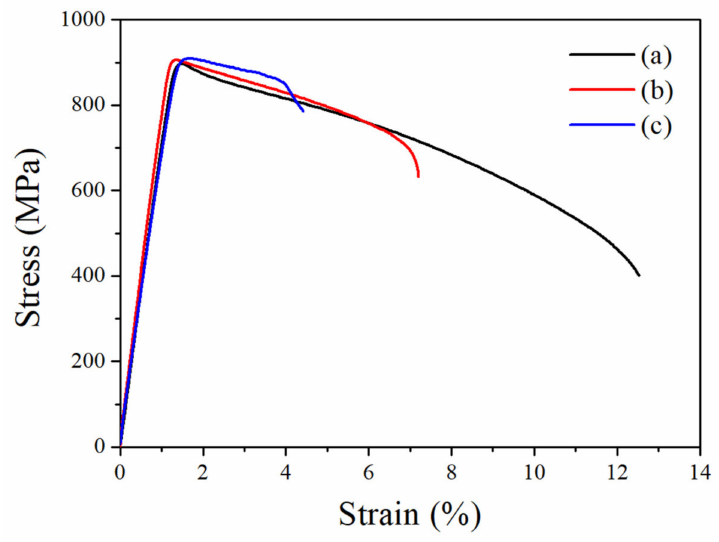
Figure 5. Tensile engineering stress-strain curves of as-swaged TNZ40 alloys; ( a ) TNZ40, ( b ) TNZ40 + 0.1 Si, and ( c ) TNZ40 + 0.2 Si.